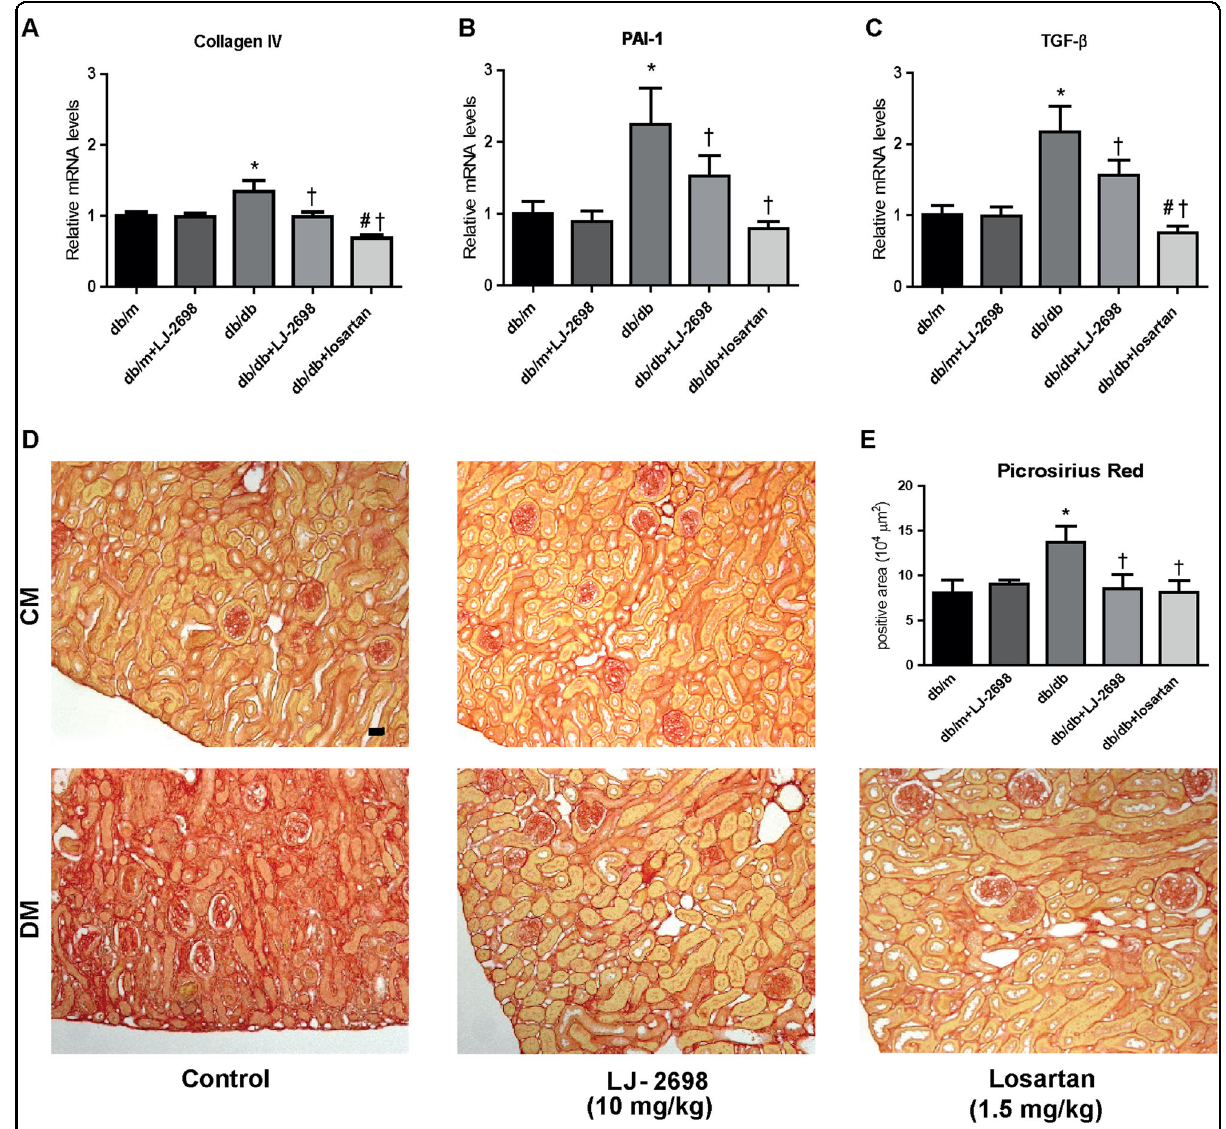
Fig. 5 LJ-2698 inhibited kidney fi brosis in db/db mice. mRNA expression levels of ( a ) type IV collagen, ( b ) PAI-1, and ( c ) TGF- β were determined by qRT-PCR. Representative photomicrographs of ( d ) picrosirius red-stained kidney sections are displayed. The scale bar indicates 50 μ m; the original magni fi cation was ×100. Quantitative analysis of ( e ) picrosirius red in kidney cortex is depicted. CM control mice; DM db/db diabetic mice. Data are presented as the mean ± SE of 7 – 10 mice/group. * p < 0.05 vs. db/m, † p < 0.05 vs. db/db, and # p < 0.05 vs. db/db +